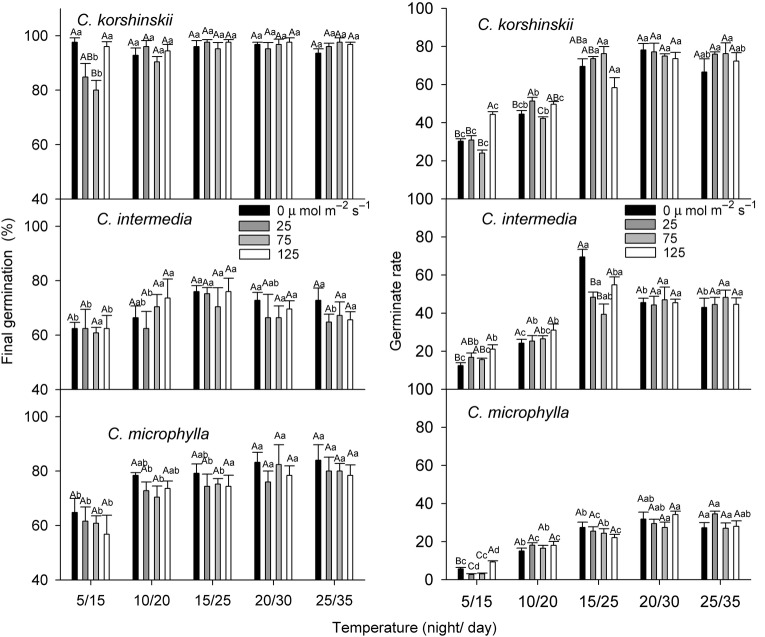
Effect of temperature and photon irradiance on FGP and GR (mean ± SE, n = 5) of three Caragana species. Different uppercase letters indicate significant differences at the same temperature under different light treatments, while different lowercase letters indicate significant differences under the same light treatment at different temperatures for the same species. P < 0.05.